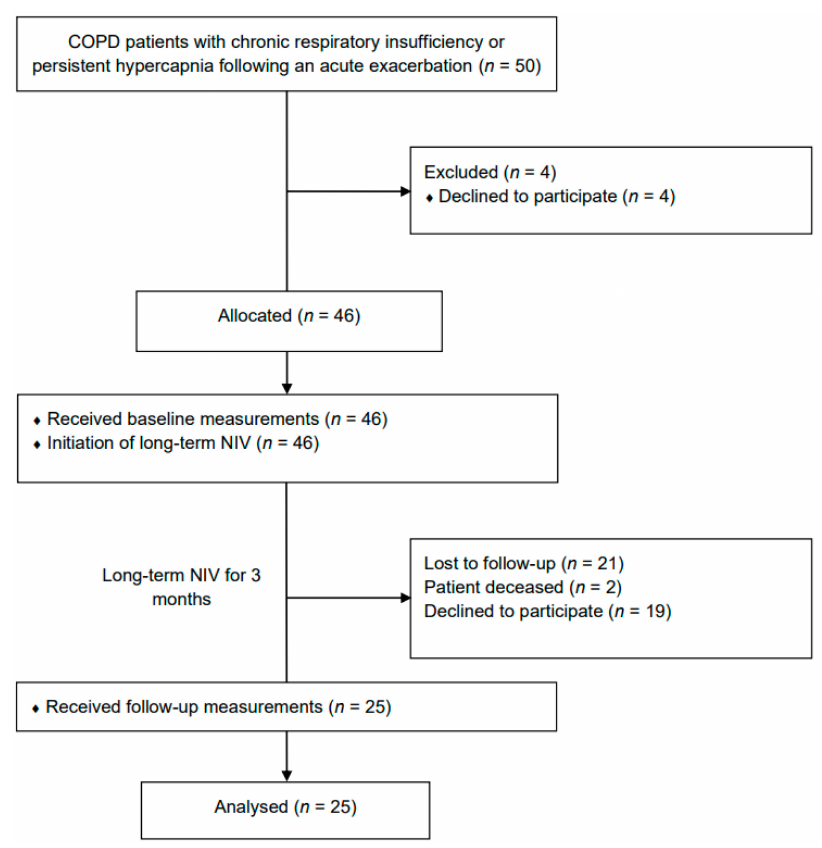
Figure 2. Flow diagram of subject recruitment and data availability. Abbreviations: n = number; NIV = non-invasive